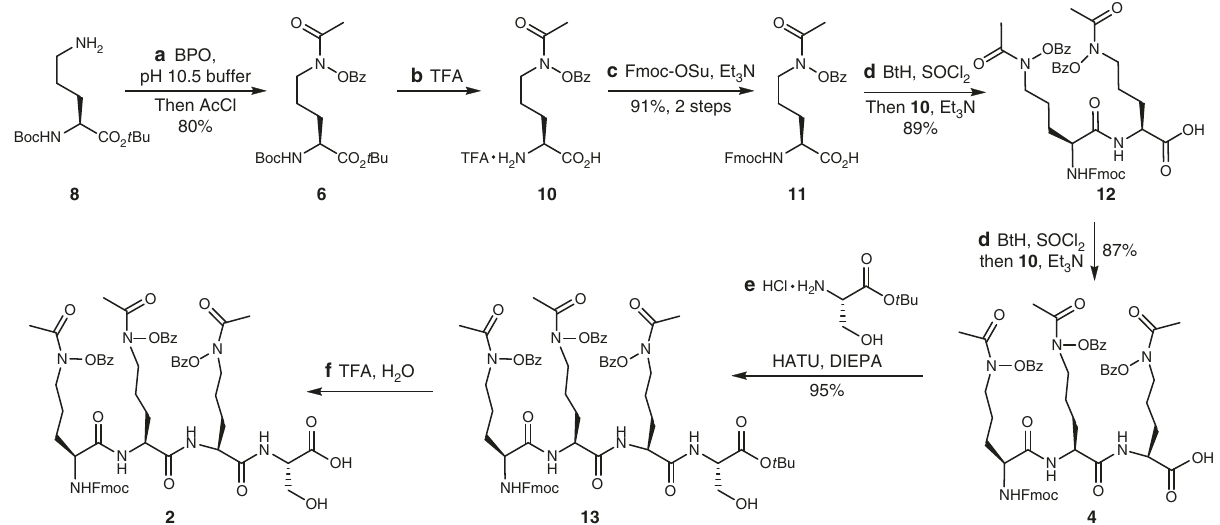
Fig. 2 Synthesis of tetrapeptide 2 . Reagents and conditions: a BPO (2.0 equiv), pH 10.5 buffer, CH 2 Cl 2 , 3 h, then AcCl (1.2 equiv), CH 2 Cl 2 , 80%; b TFA, H 2 O, 12 h; c Fmoc-OSu (1.2 equiv), Et 3 N (3.0 equiv), DMF, − 15 °C, overnight, 91% (2 steps); d BtH (4.0 equiv), SOCl 2 (1.0 equiv), THF, 50 min, then 10 (1.1 equiv), Et 3 N (3.1 equiv), CH 3 CN/H 2 O (5:2), − 15 °C, 2 h, 12 : 89%, 4 : 87%; e H-Ser( t Bu)-O t Bu hydrochloride (1.1 equiv), HATU (1.5 equiv), DIPEA (2.0 equiv), DMF, − 15 °C, 2 h, 95%; f TFA, H 2 O, CH 2 Cl 2 , 0 °C, 18 h. BPO benzoyl peroxide, AcCl acetyl chloride, TFA tri fl uoroacetic acid, Fmoc-OSu N -(9-